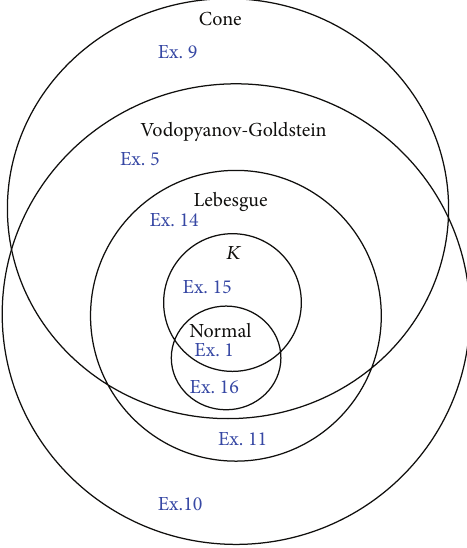
Figure 15: Types of monotonicity in higher dimensions and how they compare for a continuous